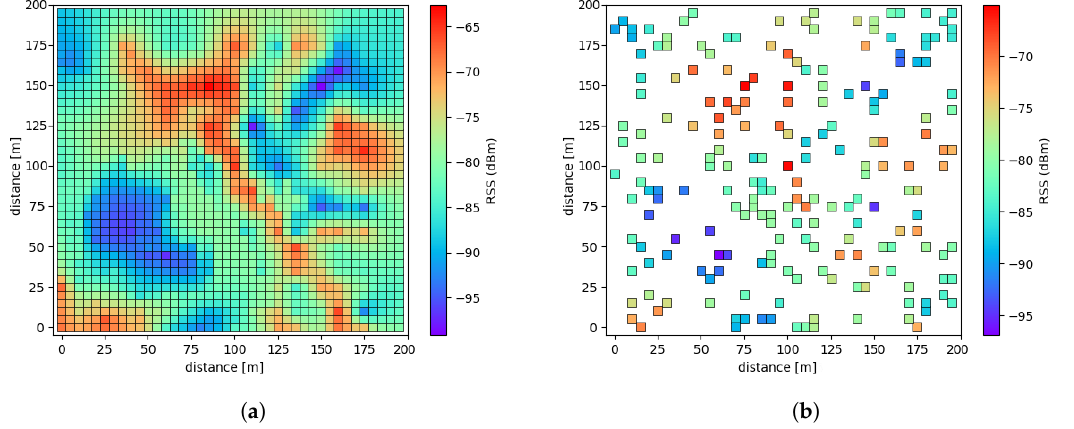
Figure 11. REM with ( a ) 1600 pixels, i.e., the original empirical sensing data (OESD) and ( b ) 200 pixels randomly